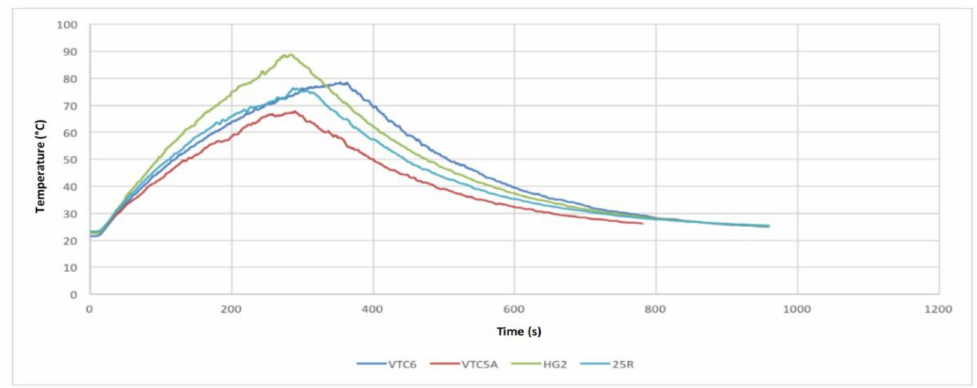
Figure 11. Single cell tests: temperatures from 30 A discharge with active air